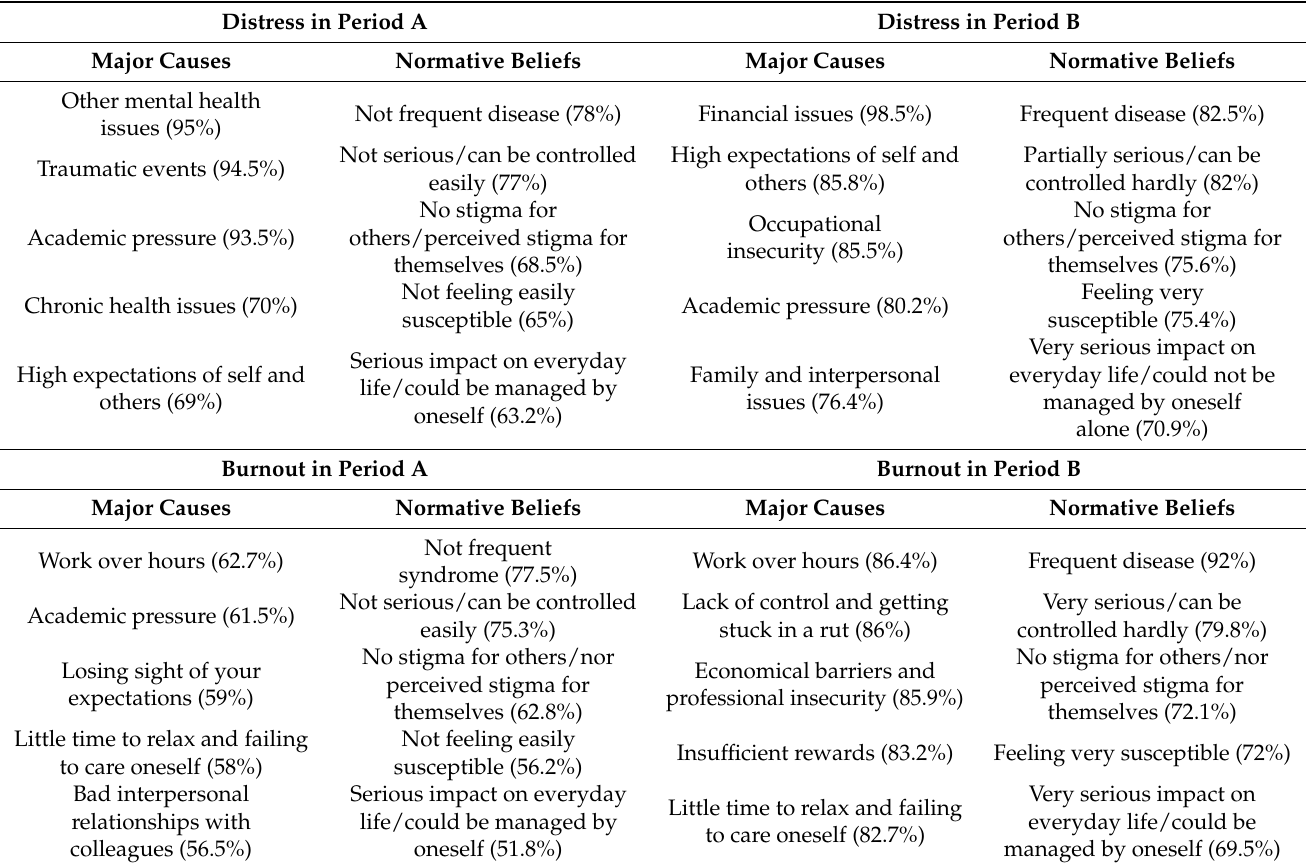
Table 2. Causes and normative beliefs on distress and burnout before (n = 518) and during (n = 518) the financial